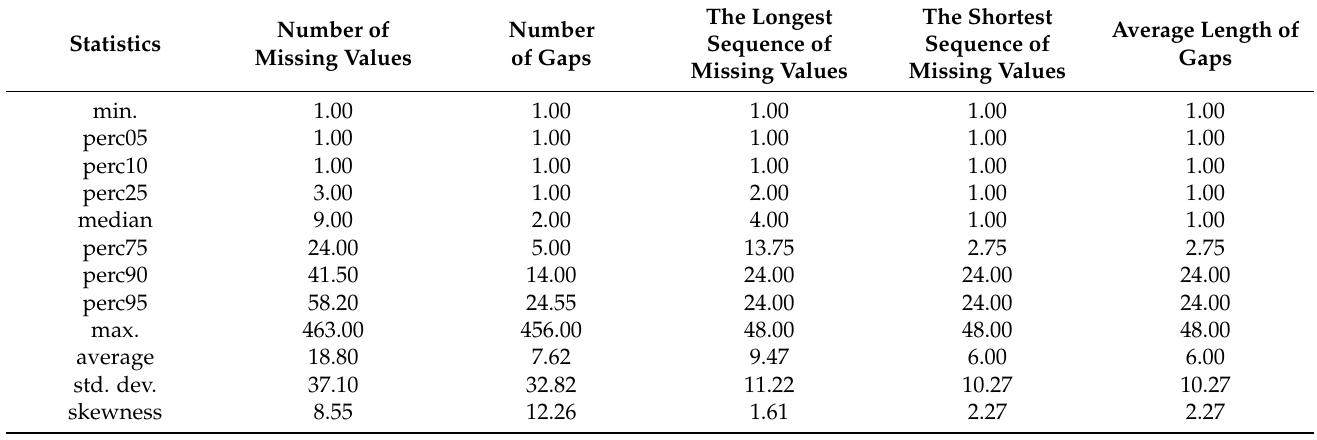
Table 1. Basic statistics of missing data.